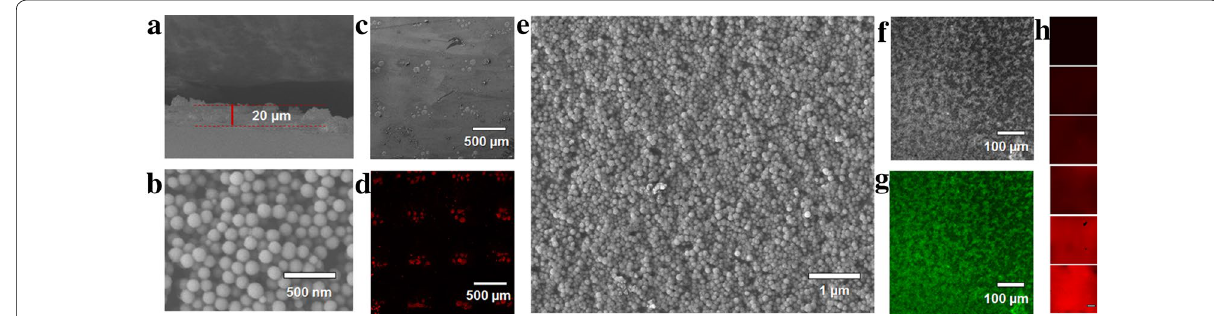
Fig. 2 SEM images of a ZIF-8 layer and b ZIF-8 nanoparticles formed on PET film printed with protein. c , d SEM and fluorescent image of rhoda- mine B-incorporated ZIF-8 formed on PET film printed with protein spots. e SEM image of Cyt c–ZIF-8 composites on hydrophilic film by one- time printing. f , g Bright-field image and fluorescent image of FITC-labeled Cyt c–ZIF-8 composites on hydrophilic film. h Fluorescent images of rhodamine B-incorporated Cyt c–ZIF-8 composites on hydrophilic film (up to down: 0, 20, 40, 60, 80, 100% K value, while C , M , Y values are 100% as constant). Scale bar is 500 Âµm long in (